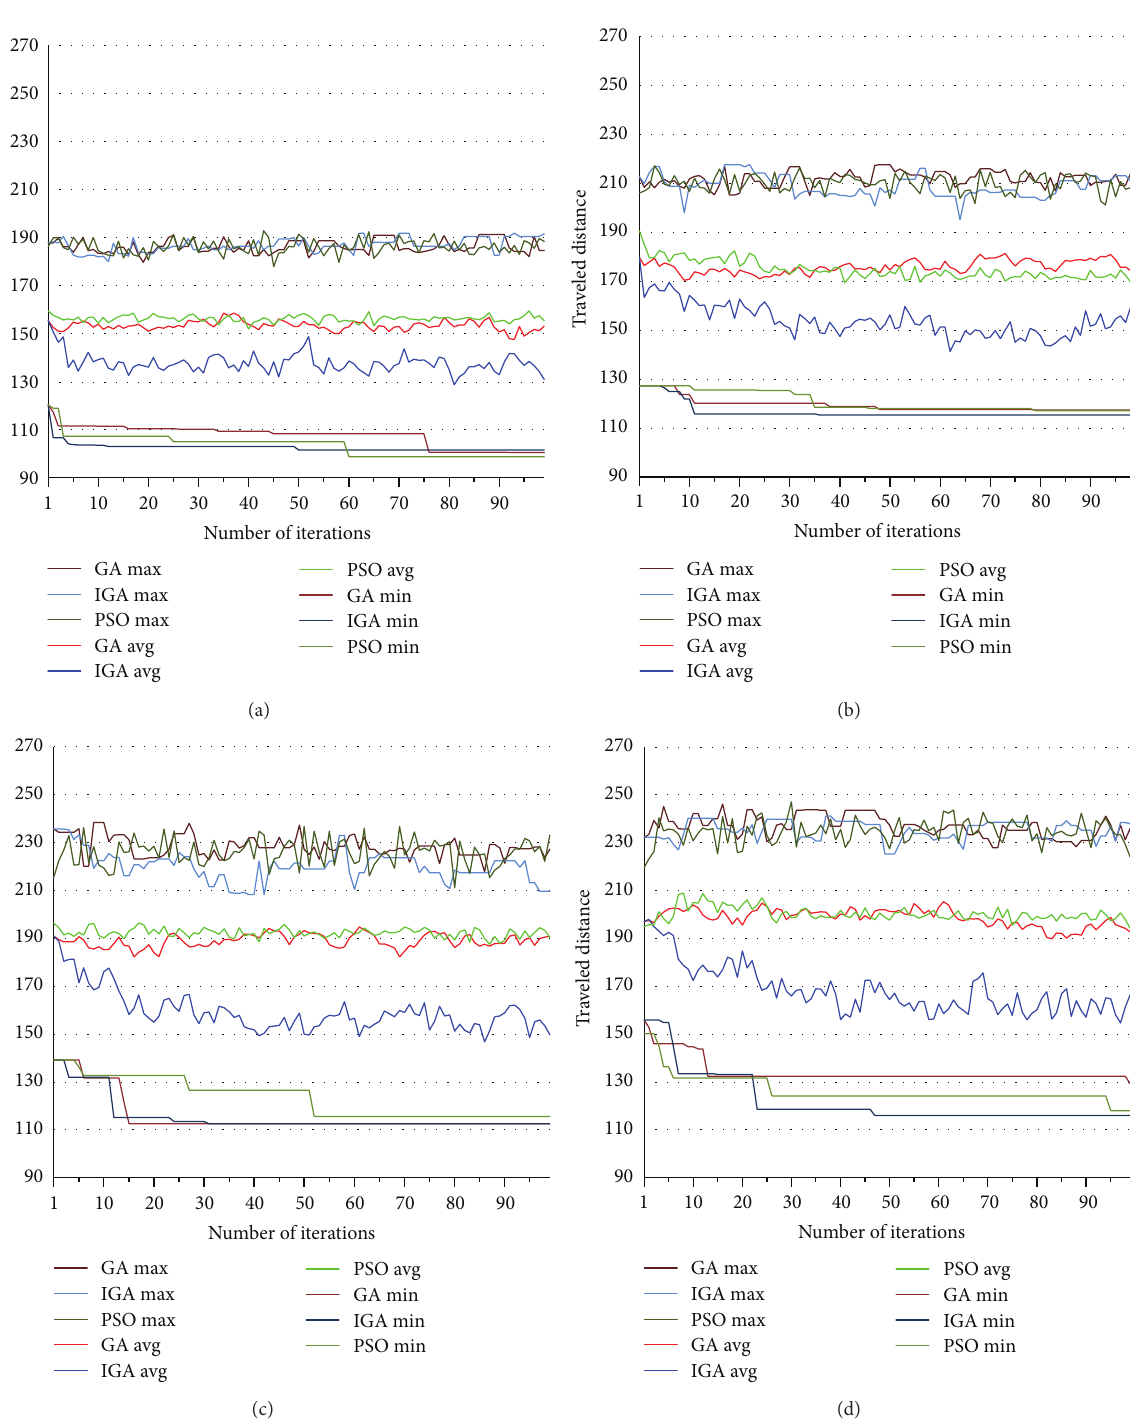
Step 9. Set 𝑡 = 𝑡 + 1 and go to Step 4, recursively. Stop if 𝑡 <